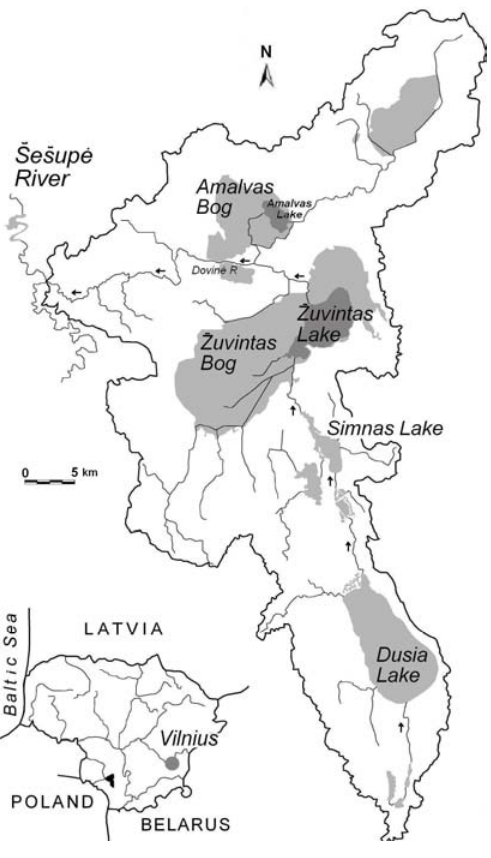
Fig. 1. Location of the Dovinė River